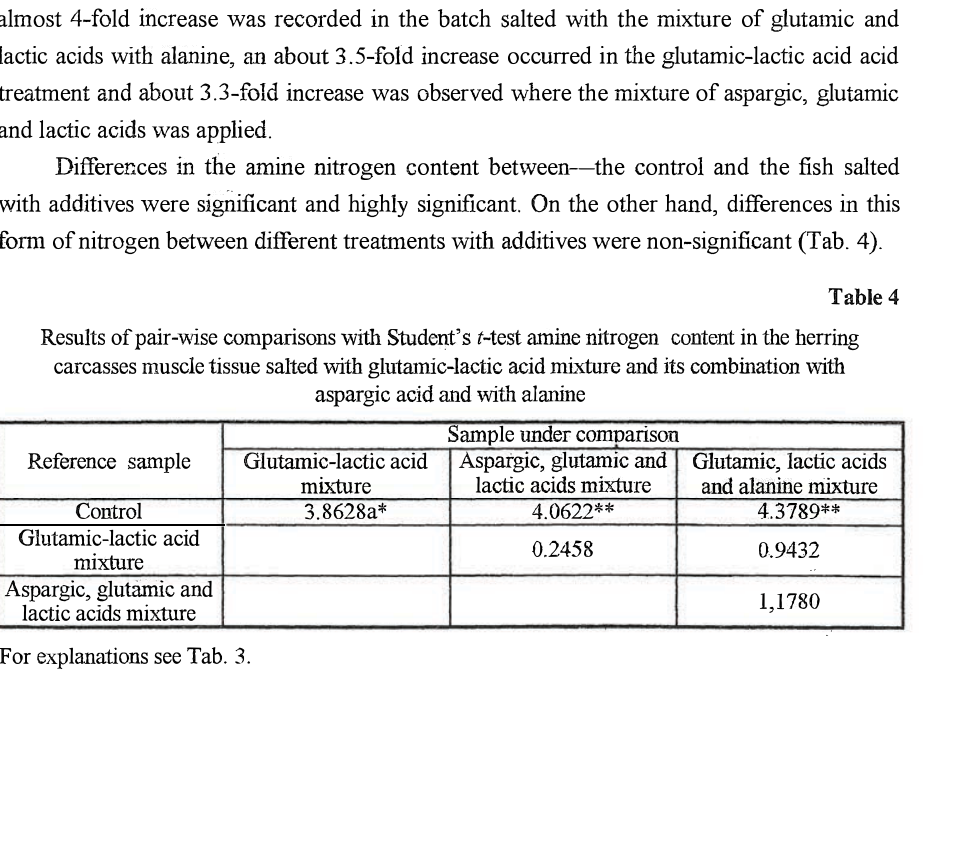
batches; however it was clearly higher in the fish salted with additives than Fig. 2. Effects of glutamic-lactic acid mi,._-ture andils combination with aspargic acid and with alanine on amine nitrogen content in in' the salt -only treatment. the salted herring muscle tissue For e1,.-planations see Fig. 1. After 6 weeks of storage, when the fish salted with additives were mature, the amine nitrogen content in the control was by about 35% higher than the initial level, whereas an alanine, an about 3.5-fold increase occurred in the glutamic-lactic acid acid the mixture of aspargic, glutamic